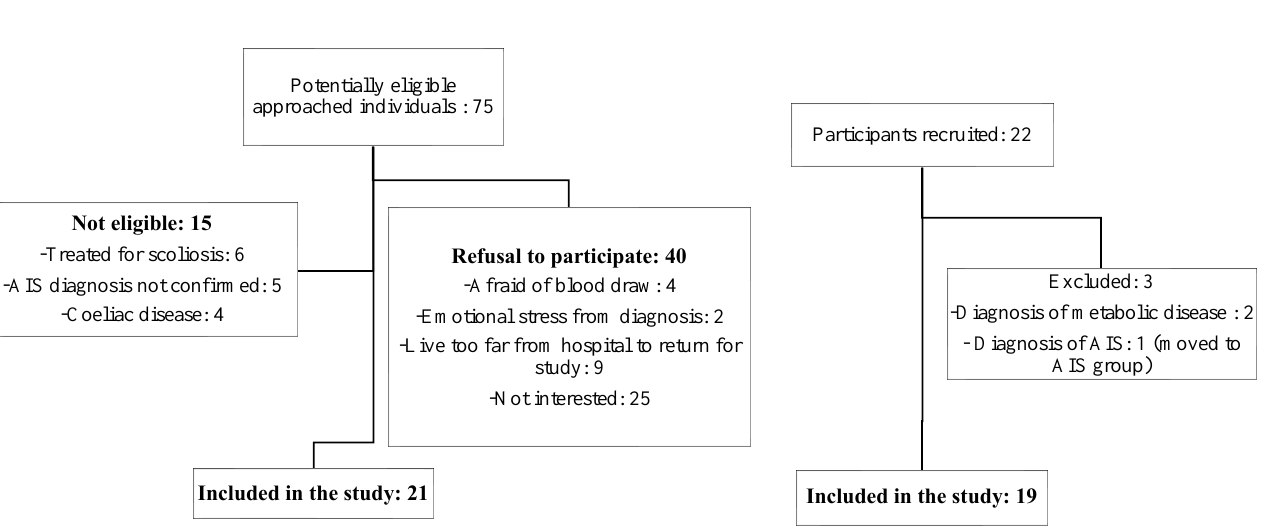
Figure 2. Flow diagram of participant recruitment. Table 1. Clinical and anthropometric characteristics of control and AIS participants.